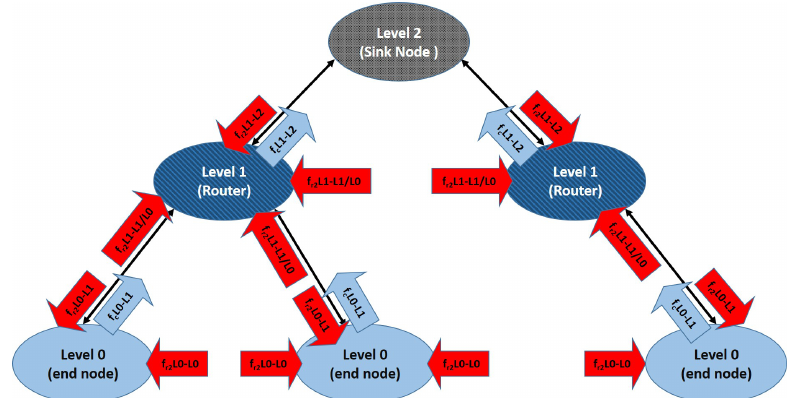
Figure 2. Forces involved in hierarchical network deployment and self-healing.